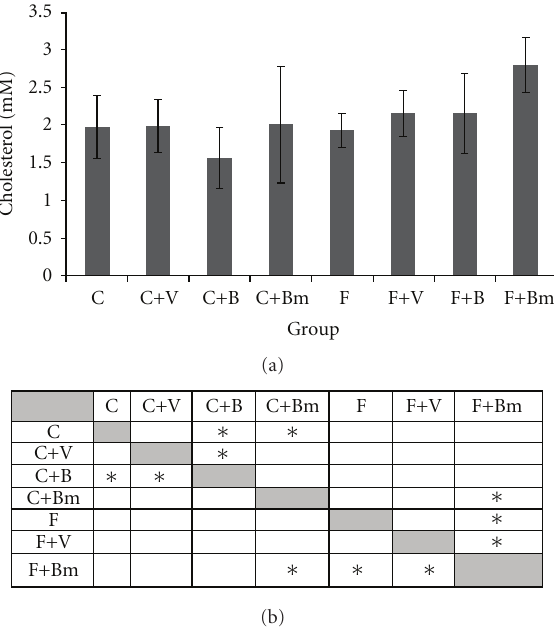
Figure 2: E ff ects of vanadium complex V, B, and Bm on plasma of total cholesterol of Wistar rats. Data are presented as mean ± SD for n = 6. (b) Statistical di ff erences between groups P <